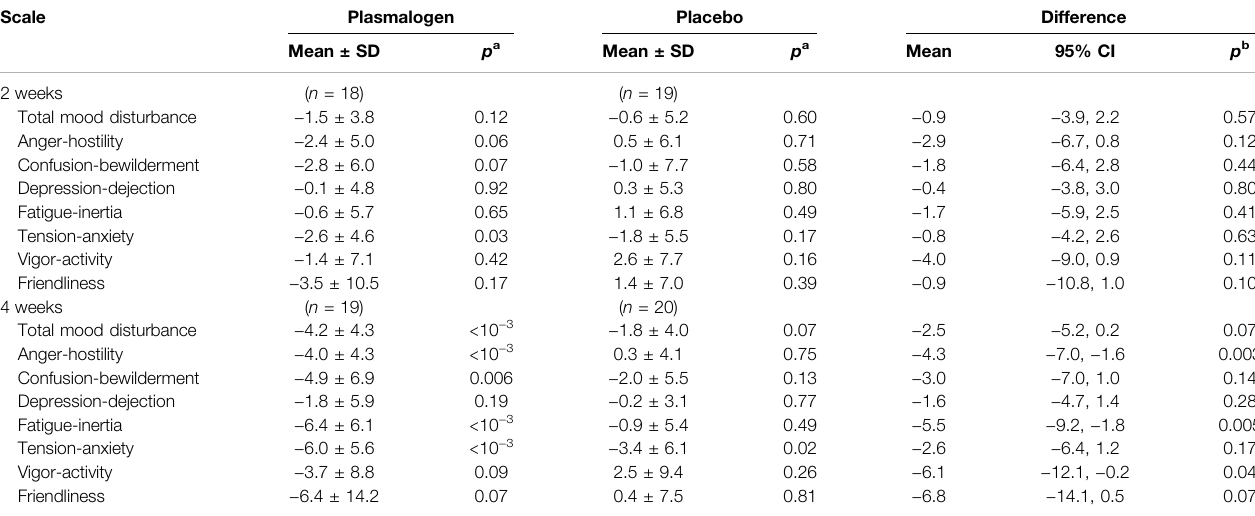
TABLE 4 | Changes of POMS 2 T-scores from baseline at 2 and 4 weeks in plasmalogen and placebo groups. Scale